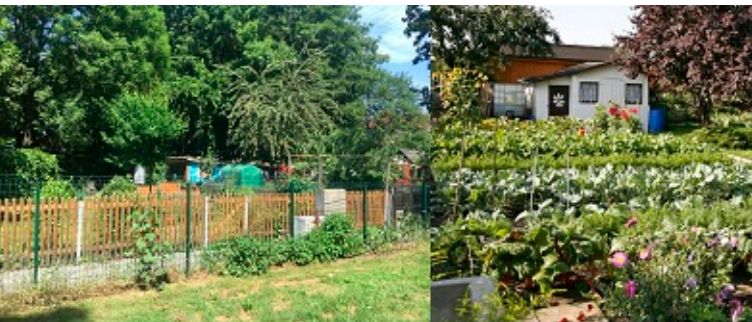
Figure 5. Green belt of Leipzig (dark green = ‘Inner Green Belt’; light green = ‘Outer Green Belt’). Source: Administrative Office of Green Ring Leipzig—https://gruenerring-leipzig.de/wp- content/uploads/2017/06/grünerring-kurzinhalt2.pdf.